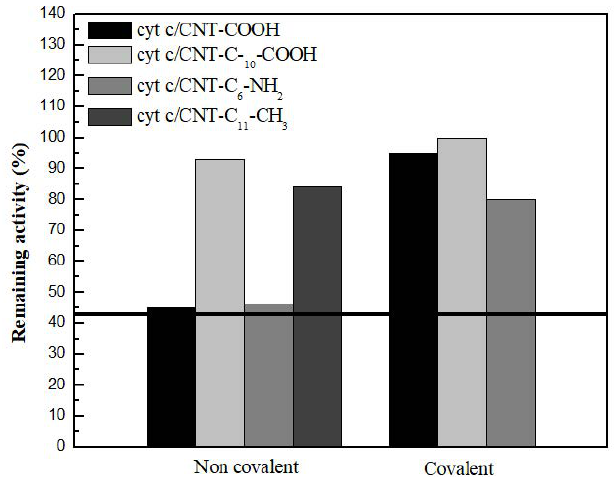
Fig. 3. Stability of free and immobilized cyt c on f-MWCNTs in buffer, after incubation for 30 min with H O . As 100% is indicated the peroxidase activity 2 2 of cyt c at t = 0 min. The line refers to the residual activity of free cyt